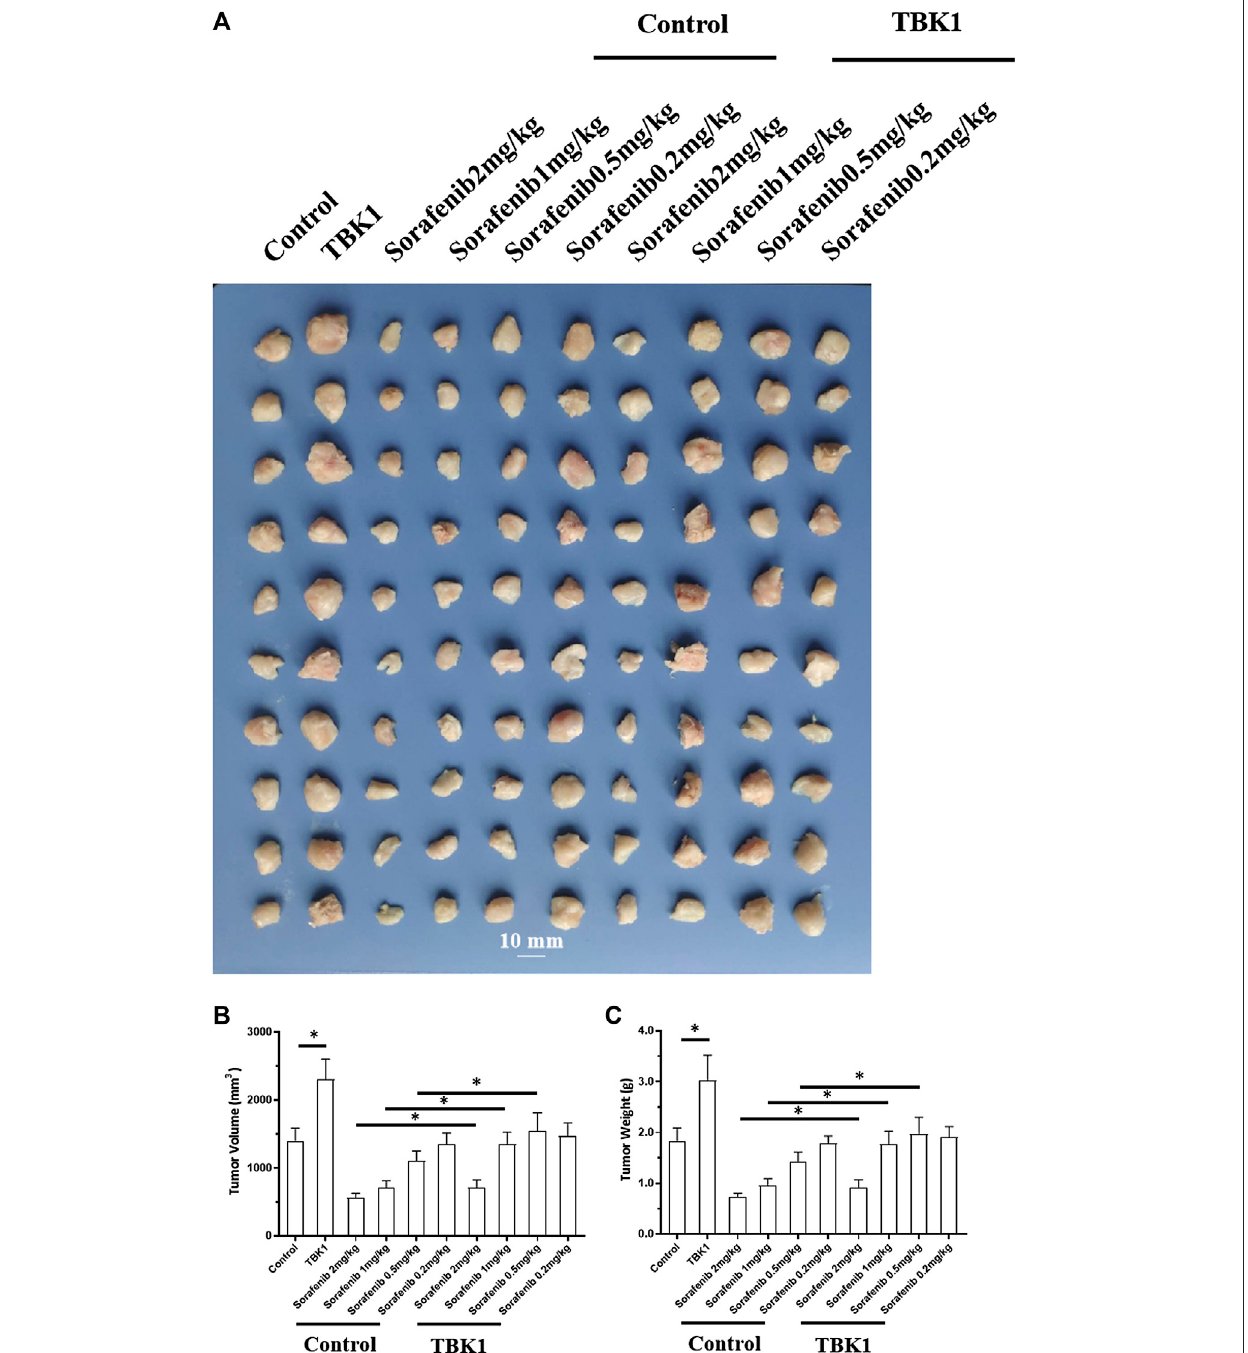
Frontiers in Pharmacology |